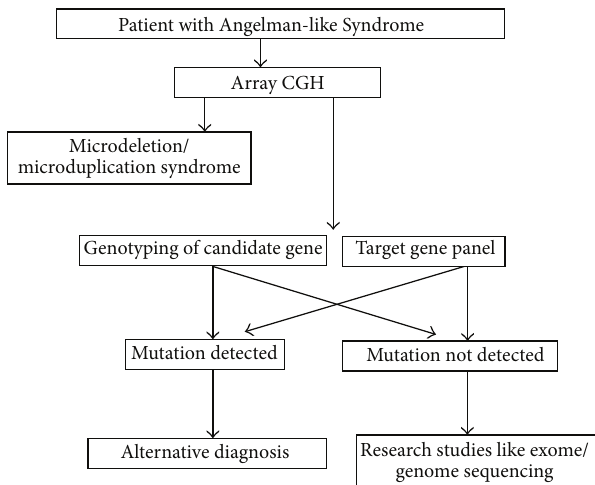
Figure 2: The genetic diagnostic algorithm of Angelman-like